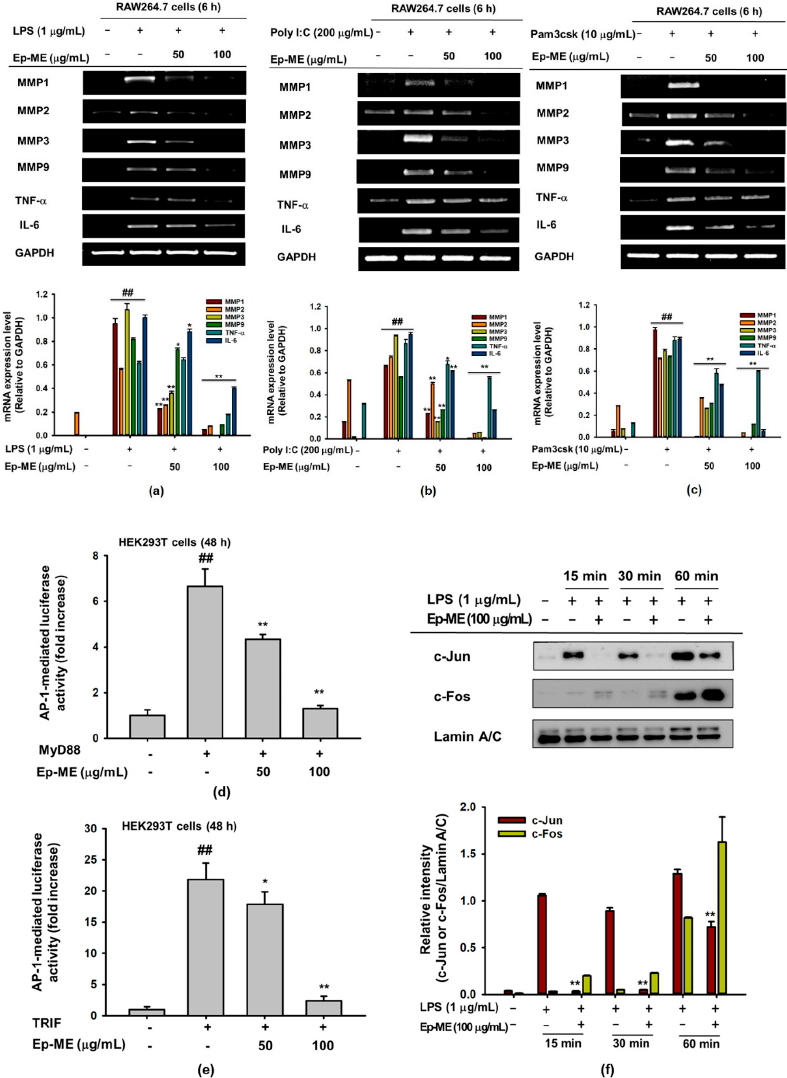
Figure 2. The effects of Ep-ME on the expression of inflammatory genes and transcription factor activation. The mRNA expression levels of MMP1, IL-6, MMP2, TNF- α , MMP3, and MMP9 in ( a ) LPS (1 μ g/mL)-, ( b ) poly I:C (200 μ g/mL)-, or ( c ) Pam3CSK (10 μ g/mL)-induced macrophages treated with Ep-ME were measured by semiquantitative RT-PCR. The relative intensity is quantified through ImageJ. HEK293T cells transfected with ( d ) MyD88 or ( e ) TRIF were transfected with plasmid constructs of AP-1-Luc for 24 h, followed by treatment with Ep-ME for an additional 24 h. ( f ) The nuclear fraction of LPS-stimulated RAW264.7 cells was analyzed using immunoblotting to determine the nuclear translocation levels of the AP-1 subunit (c-Jun and c-Fos) and Lamin A / C. The data presented in ( a – f ) are a representative of three independent experiments. ## p < 0.01 vs. untreated control group, and * p < 0.05 and ** p < 0.01 vs. control